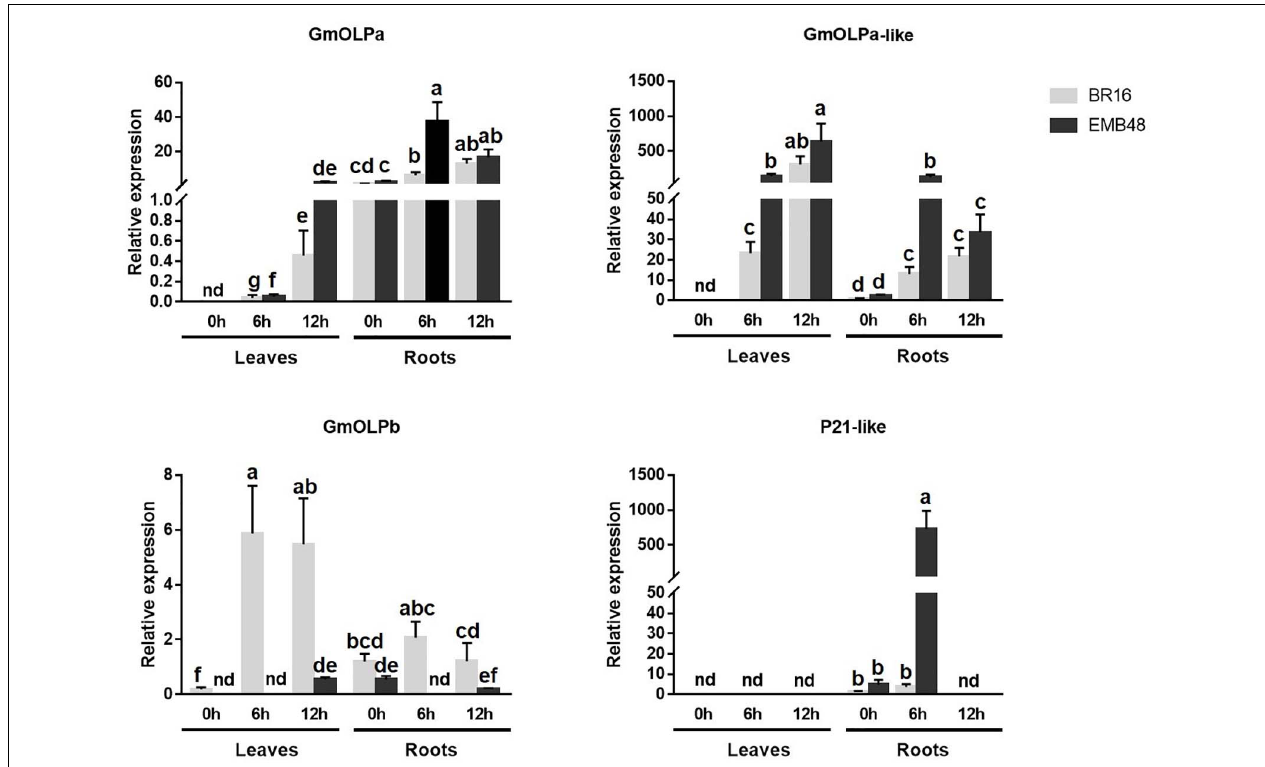
FIGURE 7 | Gene expression analyses in a growth chamber experiment of plants at the V3 development stage submitted to drought stress. The relative expression levels of genes in leaves and roots were measured by RT-qPCR at 0 (control), 6, and 12 h after dehydration treatment. CYP2 and ELF1A reference genes were used as internal controls to normalise the amount of mRNA present in each sample. All transcript levels were calibrated in relation to the expression level of BR16 roots at 0h. Data represent the means of five biological replicates with three technical replicates each. Means labelled with the same letter do not differ significantly (Duncan’s test, p < 0.05). Error bars represent the standard error of the mean. Nd, not